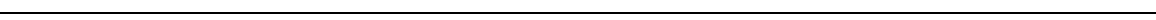
Fig. 3 C-terminally truncated sortilin strongly interacts with EGFR at the cell surface independently of ligand stimulation. a HEK293 cells were transiently transfected with either full-length (FL) or C-terminally truncated ( Δ c) sortilin-GFP. Cells were fi xed and immunolabeled for the trans-Golgi network marker TGN46, and then analyzed by confocal microscope. Scale bar, 10 µ m. b Bars show the Mander ’ s coef fi cient, indicating that FL-sortilin-GFP co-localized with TGN46 to a greater degree than Δ c-sortilin-GFP. c Bars show quanti fi cation of cell surface GFP intensity. d Strong interaction between EGFR and Δ c-sortilin at the plasma membrane. HEK293 cells were transiently co-transfected with EGFR and FL- or Δ c sortilin-GFP, and then fi xed and immunolabeled for EGFR; immuno fl uorescence was analyzed by confocal microscopy. Scale bar, 10 µ m. e HEK293 cells were transiently co-transfected with EGFR and FL or Δ c sortilin-v5. Immunoprecipitations (IP) were performed using anti-v5 antibody, and immunocomplexes were analyzed by western blotting using anti-EGFR antibody. In parallel, immunoblots of EGFR and sortilin-v5 were performed on whole-cell lysate (WCL). f HEK293 cells were transiently co-transfected with EGFR-GFP and FL- or Δ c sortilin. Next, cells were stimulated or not with EGF (50 ng/mL) for 30 min and immunoprecipitated using anti-GFP antibody. Immunocomplexes were analyzed by western blotting for sortilin. In parallel, immunoblots of P-EGFR, EGFR, P-ERK, and ERK were performed on WCL. g HEK293 cells were transiently co-transfected with Δ C sortilin and the myc-tagged extra- or intracellular domain (ECD and ICD, respectively). Next, cell lysates (CL) were immunoprecipitated (IP) with anti-sortilin and immunoblotted with anti-myc. h NSCLC cell lines harboring EGFR deletion (H1650) or point mutations (H3255, H1975) were stimulated or not with EGF (50 ng/mL) for 30 min. Cell lysates were immunoprecipitated (IP) using anti-sortilin, and immunocomplexes were analyzed by western blotting with anti-EGFR. i PLA quanti fi cation performed on NSCLC cell lines stimulated or not with EGF (50 ng/mL) for 30 min. j Proximity ligation assays (PLA) were performed on NSCLC cells under the same conditions as described in h . All values represent means ± SD, Student ’ s t -test *** P < 0.001. Each experiment has been repeated at least three